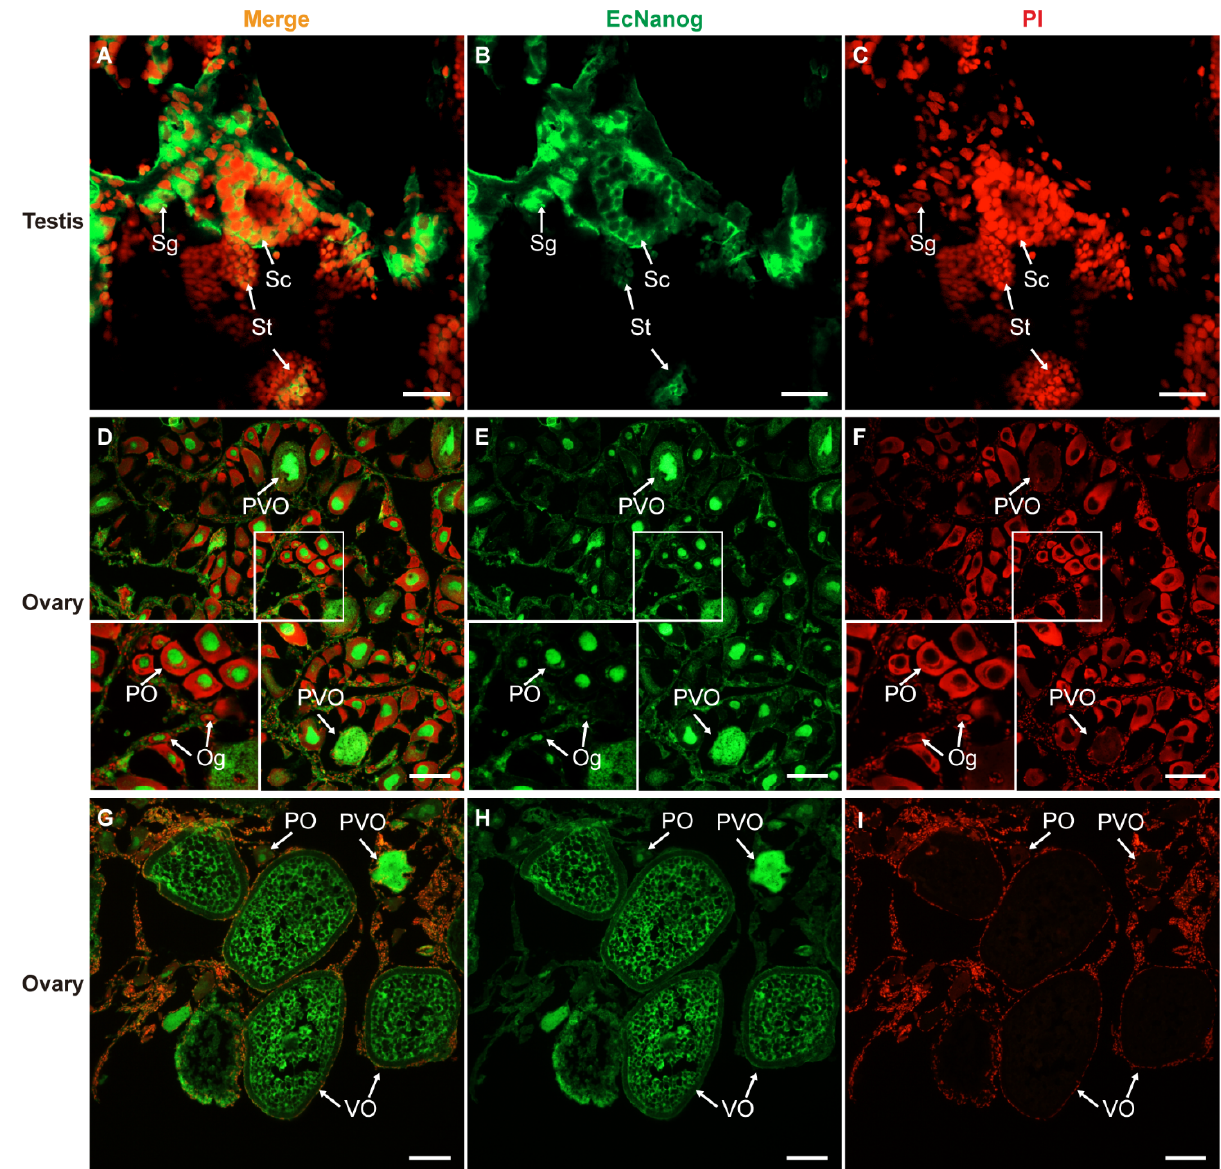
Figure 9. Immunohistofluorescence staining for anti-Nanog antibody in gonads of orange-spotted grouper. ( A , D , G ) Merged images. ( B , E , H ) Fluorescent signal of anti-Nanog antibody in testis and ovaries. ( C , F , I ) Nucleus was counterstained with PI. Sg, Spermatogonium; Sc, Spermatocyte; St, spermatid; Og, oogonium; PO, primary growth stage oocyte; PVO, the cortical-alveolus stage oocyte; VO, vitellogenic stage oocyte. Scale bars: 20 µ m in ( A – C ); 100 µ m in ( D – I